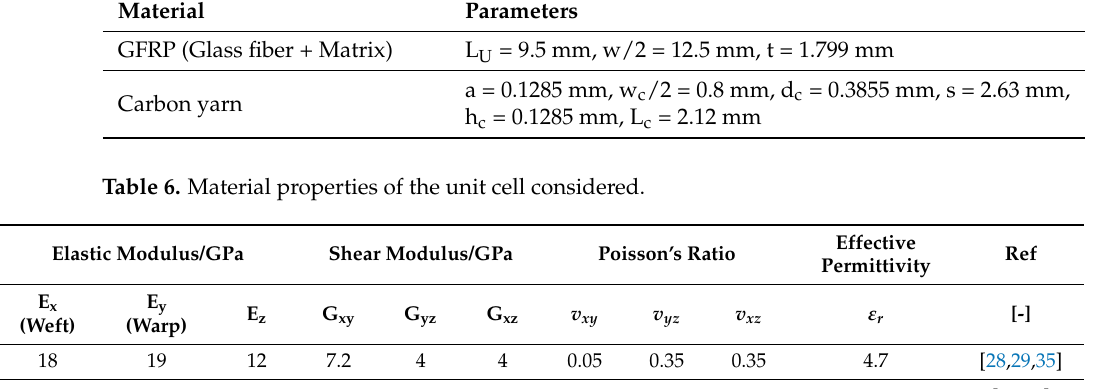
Table 6. Material properties of the unit cell considered.